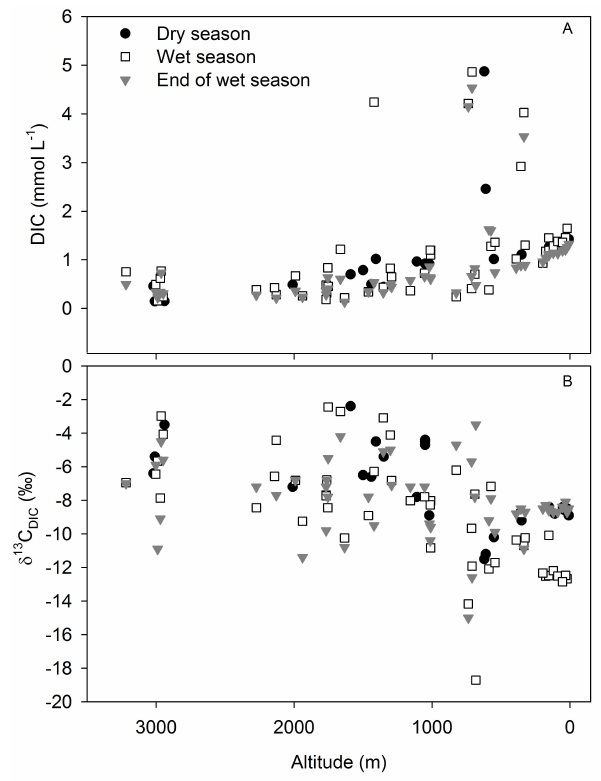
Fig. 4. Altitudinal profiles of (A) dissolved inorganic carbon con- centrations and (B) δ 13 C DIC along the Tana River basin during all three sampling seasons. Dry season data have already been pre- sented in Bouillon et al.